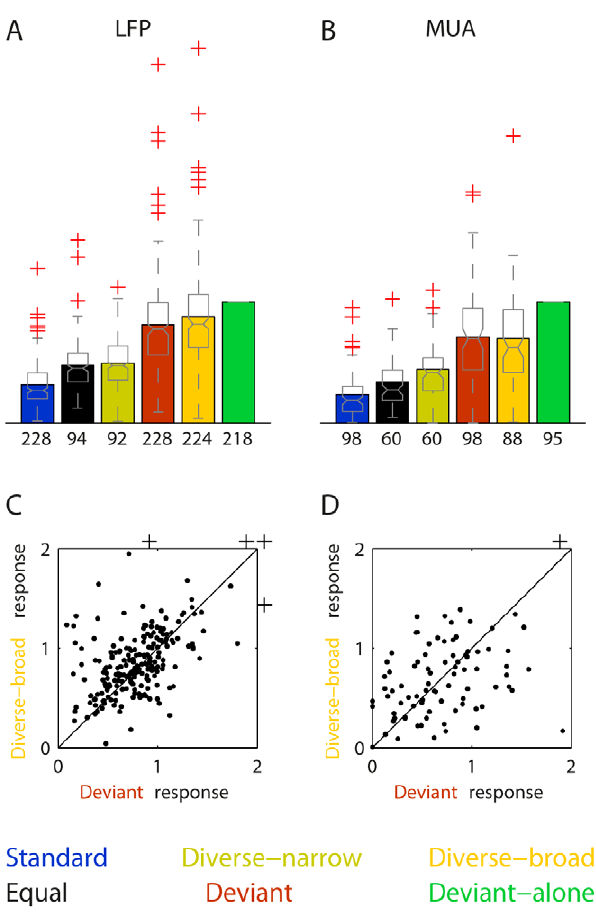
Figure 5. Summary of the responses to all conditions ( D f=44%). A and B. Average (bar plots) and distributions (summarized as box plots) of the responses (normalized with respect to the corresponding deviant-alone response) to both frequencies in each of the six conditions, in all sets recorded with D f=44%. The number of cases included in each column is displayed underneath it (not all sets included all the six conditions). A. LFP, including 114 sets recorded from 60 individual sites in 22 rats. B. MUA, including 49 sets recorded from 35 sites in 18 rats. C and D. The normalized response to in the Deviant condition (abscissa) versus the normalized response to the same tone in the Diverse-broad condition (ordinate). Each point represents one of the main frequencies (either f1 or f2) of a set in a specific recording site. C. LFP, (r=0.62, df=212, p ,, 0.001). D. MUA (r=0.40, df=83, p ,